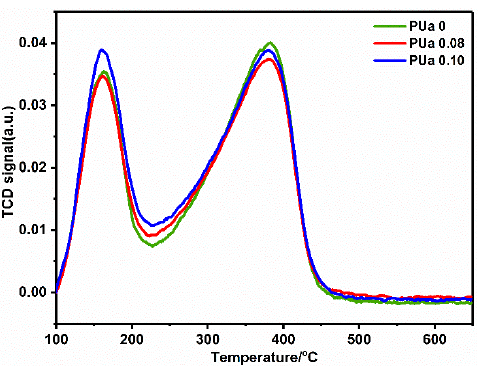
Figure 9. NH 3 -TPD curves of the SAPO-34 samples synthesized with and without PUa as mesoporogen.